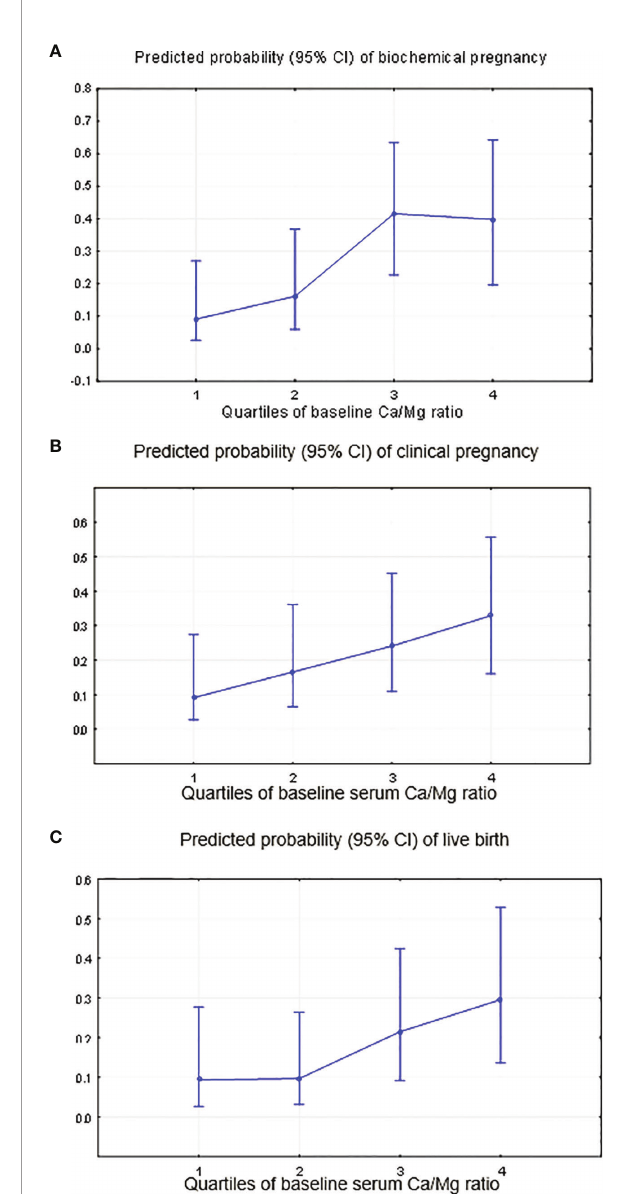
FIGURE 5 | Predicted probability of occurring “ no ” (0) or “ yes ” (1) for clinical ART outcomes by the quartiles of the serum folate level. (A) Biochemical pregnancy, adjustment for continuous red blood cells, baseline serum FSH and antithrombin. (B) Clinical pregnancy, adjustment for continuous red blood cells and baseline serum FSH. (C) Live birth, adjustment for continuous red blood cells and baseline serum FSH.